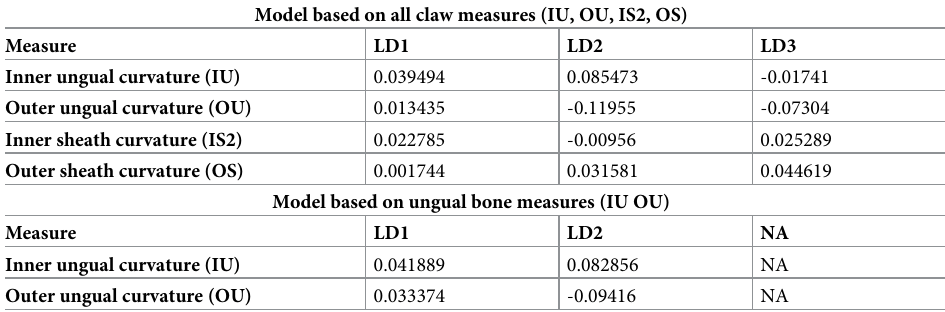
Table 4. Variance-covariance loadings for each variable included in the analysis. (A) Variance matrix based on LDA of all measures. (B) Variance matrix based on LDA of ungual bones. Model based on all claw measures (IU, OU, IS2,